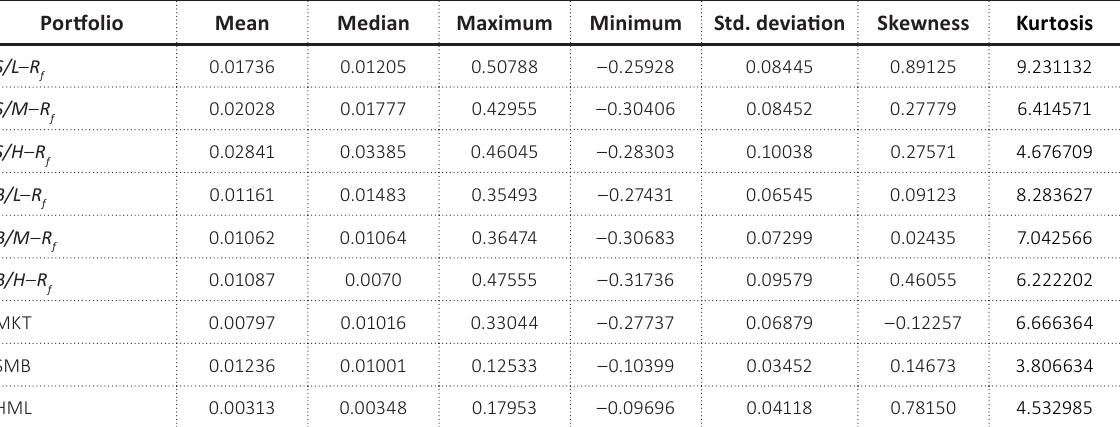
Source: Calculated by the authors based on the data available on Prowess IQ